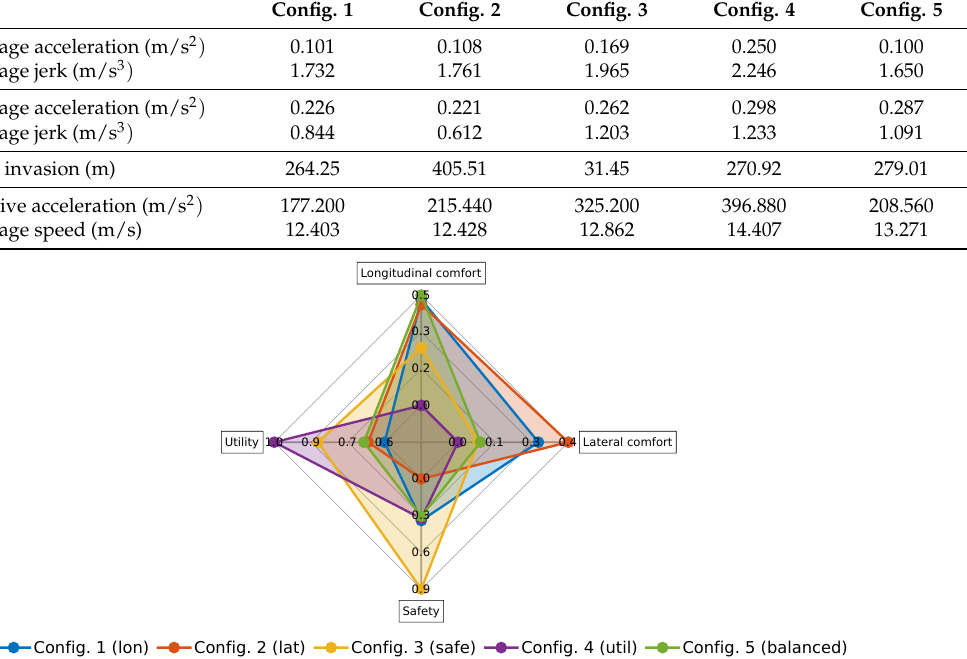
Table 7. Key performance indicators to compare the performance of different configurations in the real environment. Decision Variable